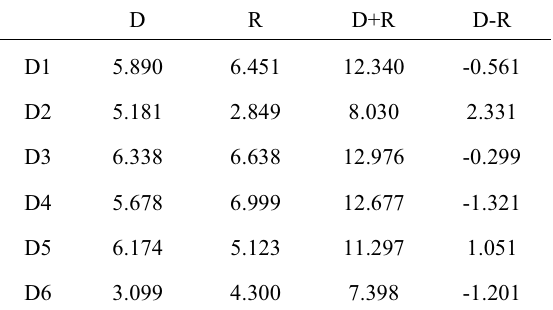
Figure 2. the Tables 5 means total effects and net effects for each factor respectively. Table 5Total Effects and Net Effects for Each